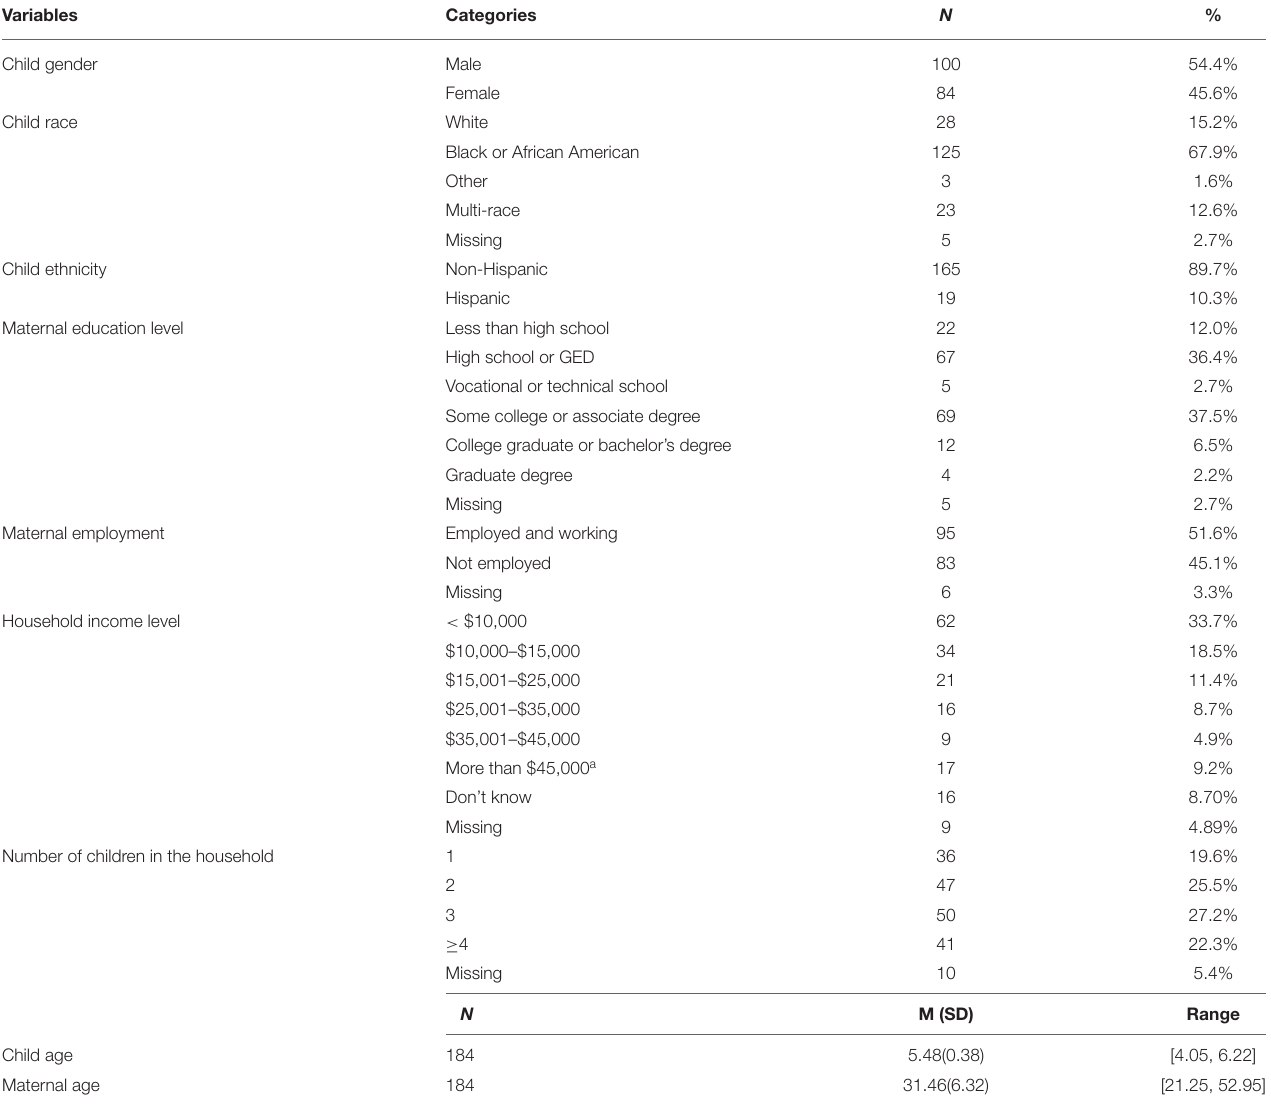
TABLE 1 | Demographic characteristics of the current sample ( N =